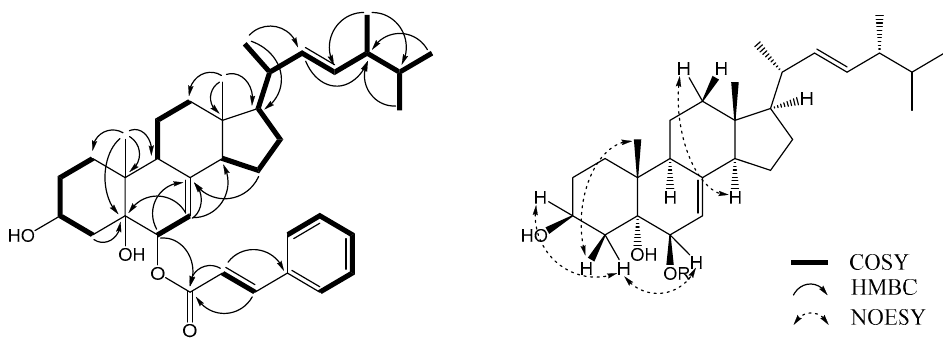
Figure 2. Key 1 H- 1 H COSY, HMBC, and NOESY correlations of compound 6 .